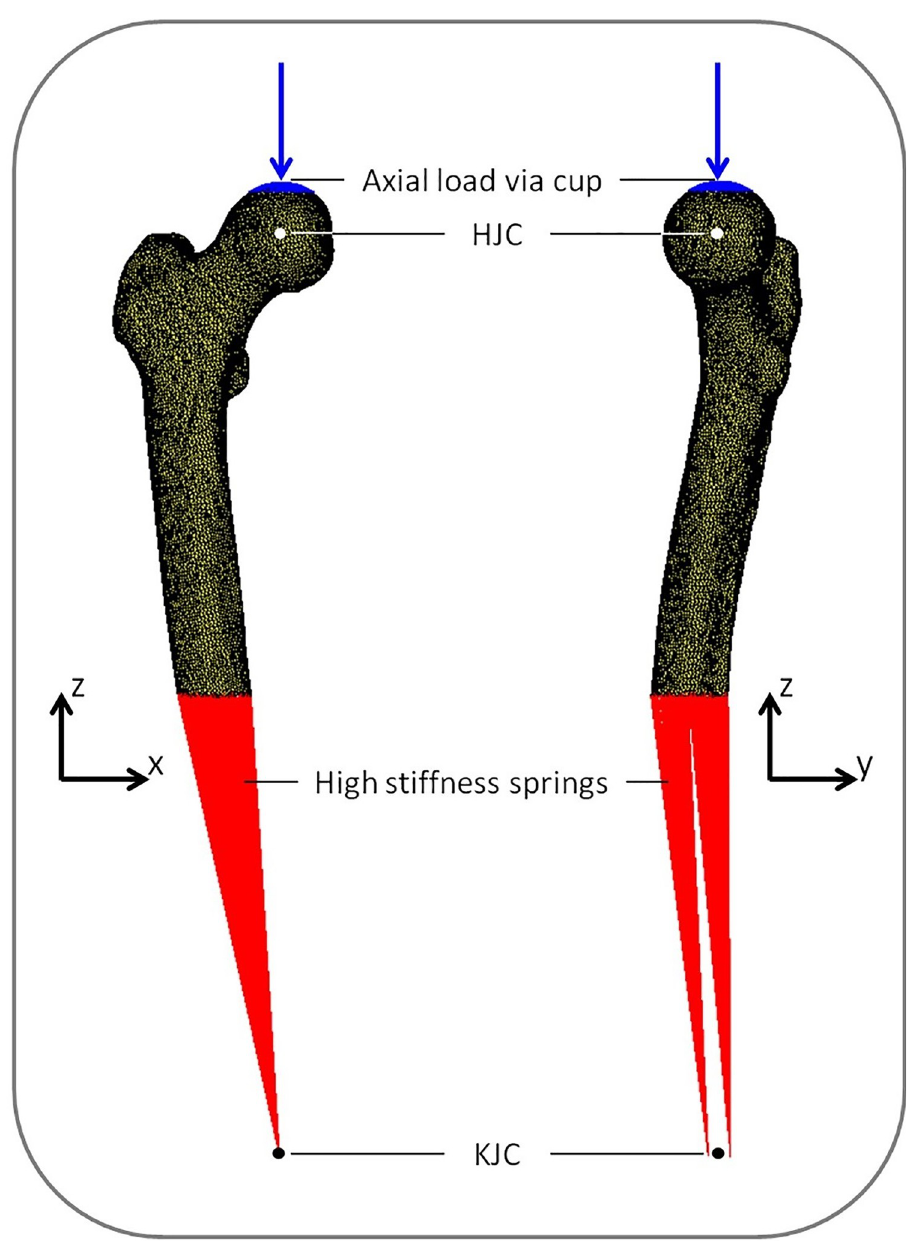
Eggermont et al., Bone, 2020